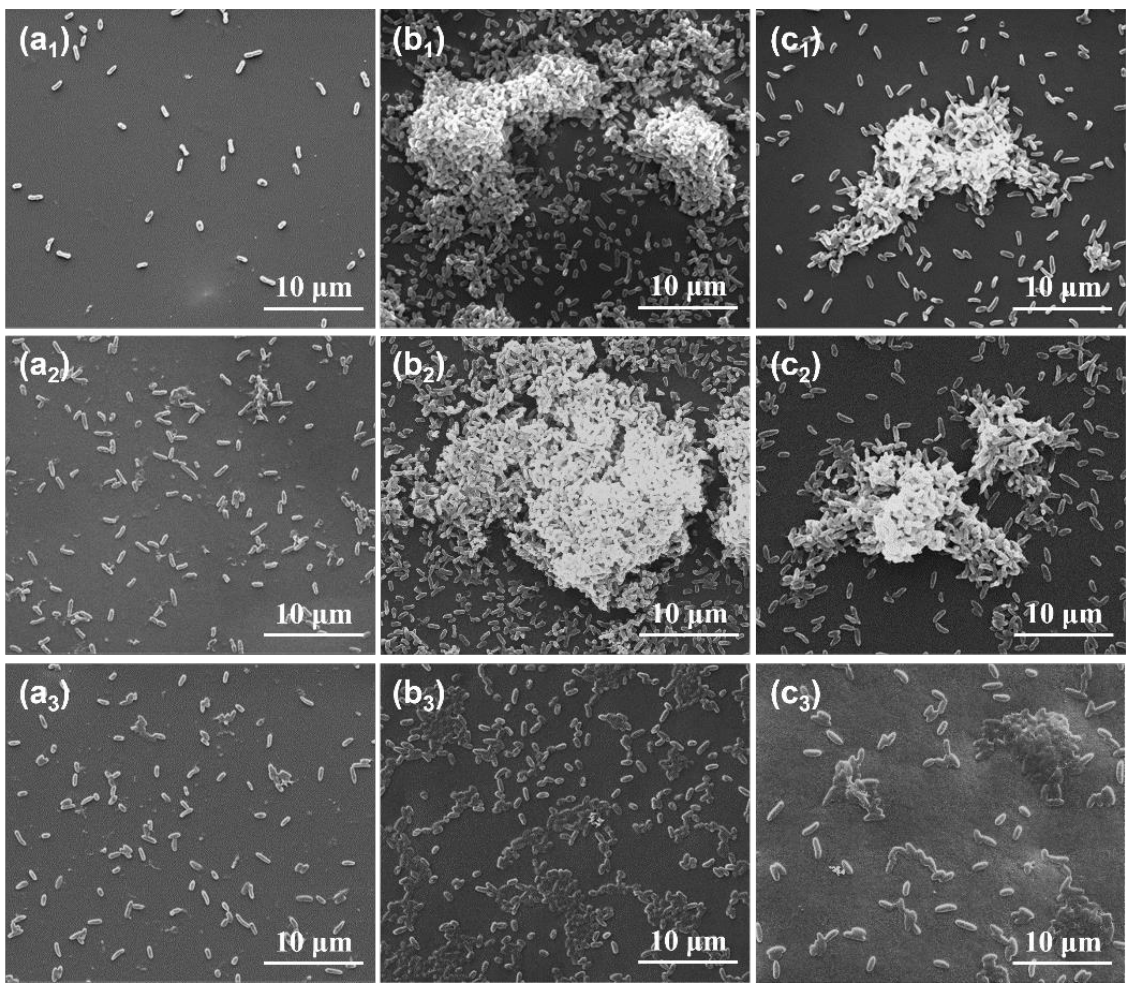
Figure 2. SEM morphologies of the coating surfaces after ( a 1 ) 3 days, ( a 2 ) 7 days, and ( a 3 ) 14 days of immersion in the 100% nutrient medium. SEM morphologies of the coating surfaces after ( b 1 ) 3 days, ( b 2 ) 7 days, and ( b 3 ) 14 days of immersion in the 10% nutrient medium. SEM morphologies of the coating surfaces after ( c 1 ) 3 days, ( c 2 ) 7 days, and ( c 3 ) 14 days of immersion in the 0% nutrient medium.